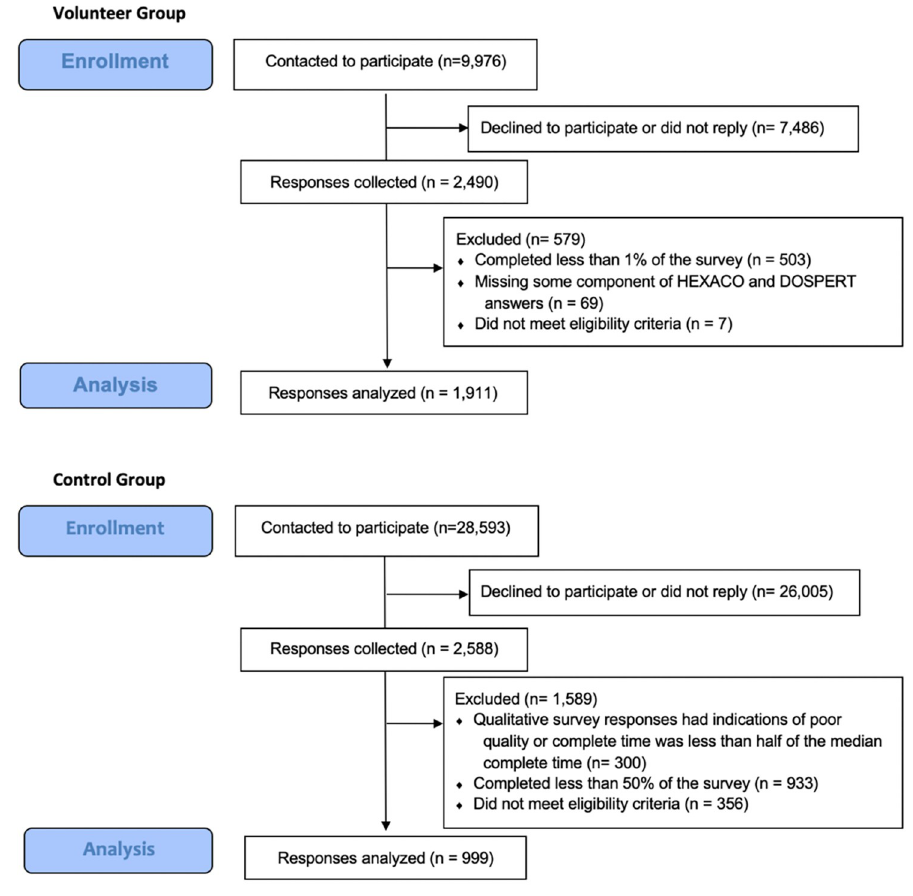
Fig 1. CONSORT diagram of volunteer and control group enrollment and analysis. 9,976 volunteers from the 1Day Sooner database who had indicated they were interested in contributing to further research were contacted to participate in this study. Of these, 7,486 volunteers did not reply or declined to participate. The remaining 2,490 volunteers completed the survey via the Qualtrics platform (25% response rate). 579 of these responses were ultimately excluded from the final analysis due to failure to complete sufficient portions of the survey, missing data, or submitting a birth date that indicated they were under 18 years of age. The remaining 1,911 responses were analyzed for inclusion in this